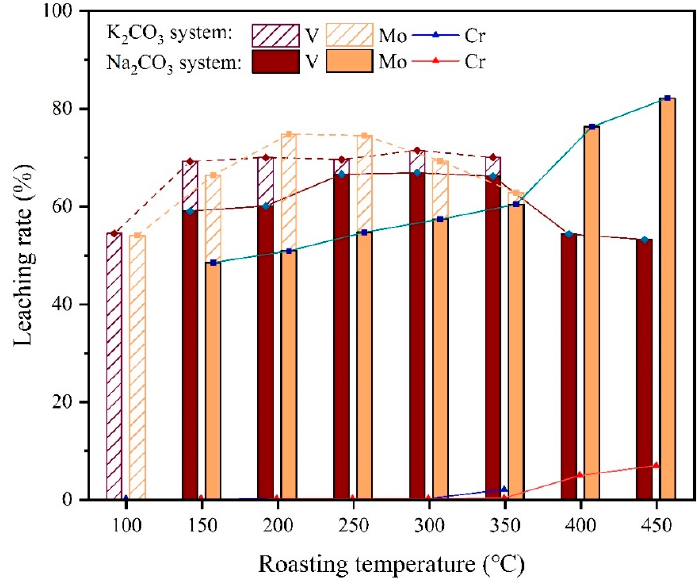
Figure 3. Effects of temperature on the leaching rates of V, Cr, and Mo.